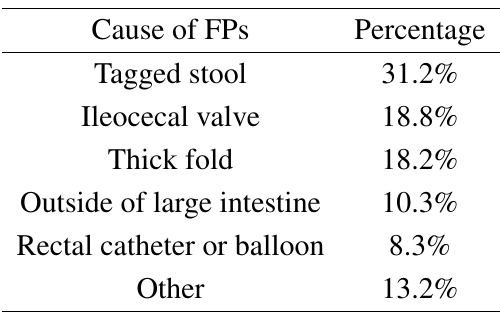
Table 4. Sources of false